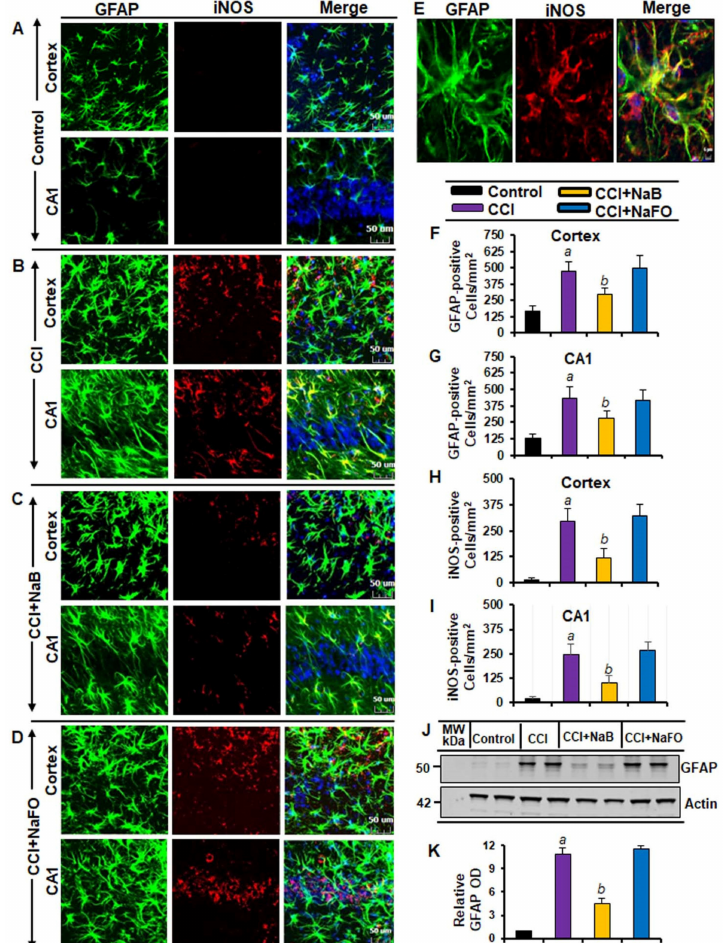
Figure 2. Oral treatment of NaB attenuates the activation of astrocytes in vivo in the cortex and hippocampus region of mice with CCI injury. Mice were treated with 50 mg/kg/day of NaB or NaFO via oral administration after the induction of CCI injury. After 7 days of NaB treatment, brain sections were analyzed by double-label immunofluorescence for GFAP and iNOS (( A ), control; ( B ), CCI injury; ( C ), CCI+NaB; ( D ), CCI+NaFO). ( E ) Confocal image demonstrating the co-localization of iNOS and GFAP in the cortex. Cells positive for GFAP were counted in the cortex ( F ) and CA1 region ( G ). Subsequently, iNOS-positive cells were also counted in the cortex ( H ) and CA1 region ( I ). Results represent analysis of six sections of six mice each per group. a p < 0.001 vs. control; b p < 0.001 vs. CCI injury. Tissue extracts of hippocampal region from all groups of mice ( n = 4 per group) were immunoblotted for GFAP ( J ). Actin was run as a loading control. ( K ) Bands were scanned, and values (GFAP/Actin) are presented as relative to control. a p < 0.001 vs. control; b p < 0.001 vs. CCI